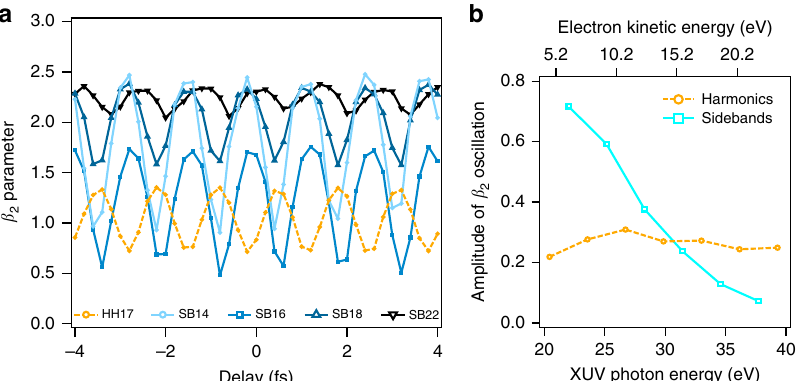
Fig. 4 Time-dependent β 2 parameters. Panel a shows the values of β 2 parameter for SB14, SB16, SB18 (blue symbols), SB22 (black symbols) and HH17 (yellow symbols), extracted from a fi t of the momentum distributions at different XUV-IR delays in the Lund experiment, for which HH17 is resonant with the 3 s − 1 4 p autoionizing state. b Amplitude of β 2 oscillations as a function of kinetic energy. For the harmonics, it is approximately constant, while it decreases for the sidebands